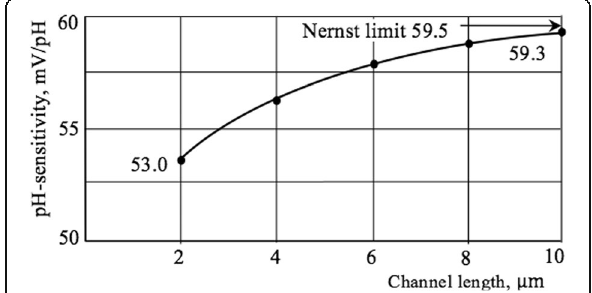
Fig. 10 pH sensitivity vs channel length. Plot of pH sensitivity as a function of channel length. V FG = − 10 V, V BG = − 5 V, V ds = − 5 V, R ch = 1.26 M Ω